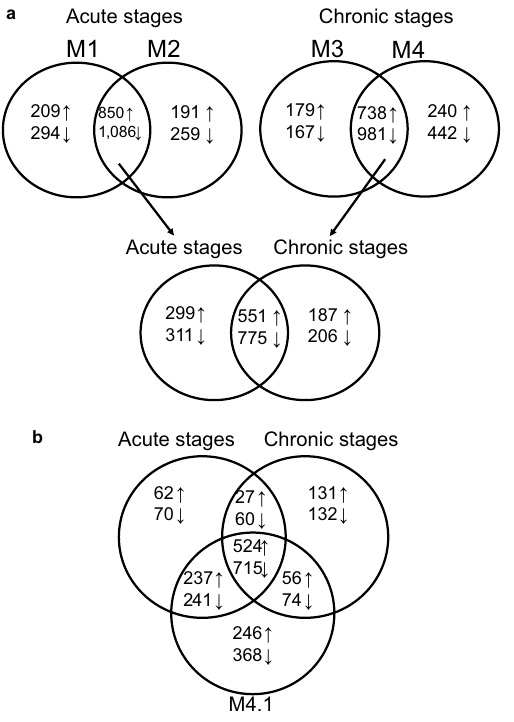
Figure 3. Visualization of the overlap and the unique subsets of the up-and downregulated genes throughout all DD stages. ( a ) the overlap and unique subsets of the up-and downregulated genes in acute (M1, M2) and chronic (M3, M4) stages. ( b ) the overlap and the unique subsets of the up-and downregulated genes throughout the acute (M1, M2), chronic (M3, M4) and M4.1